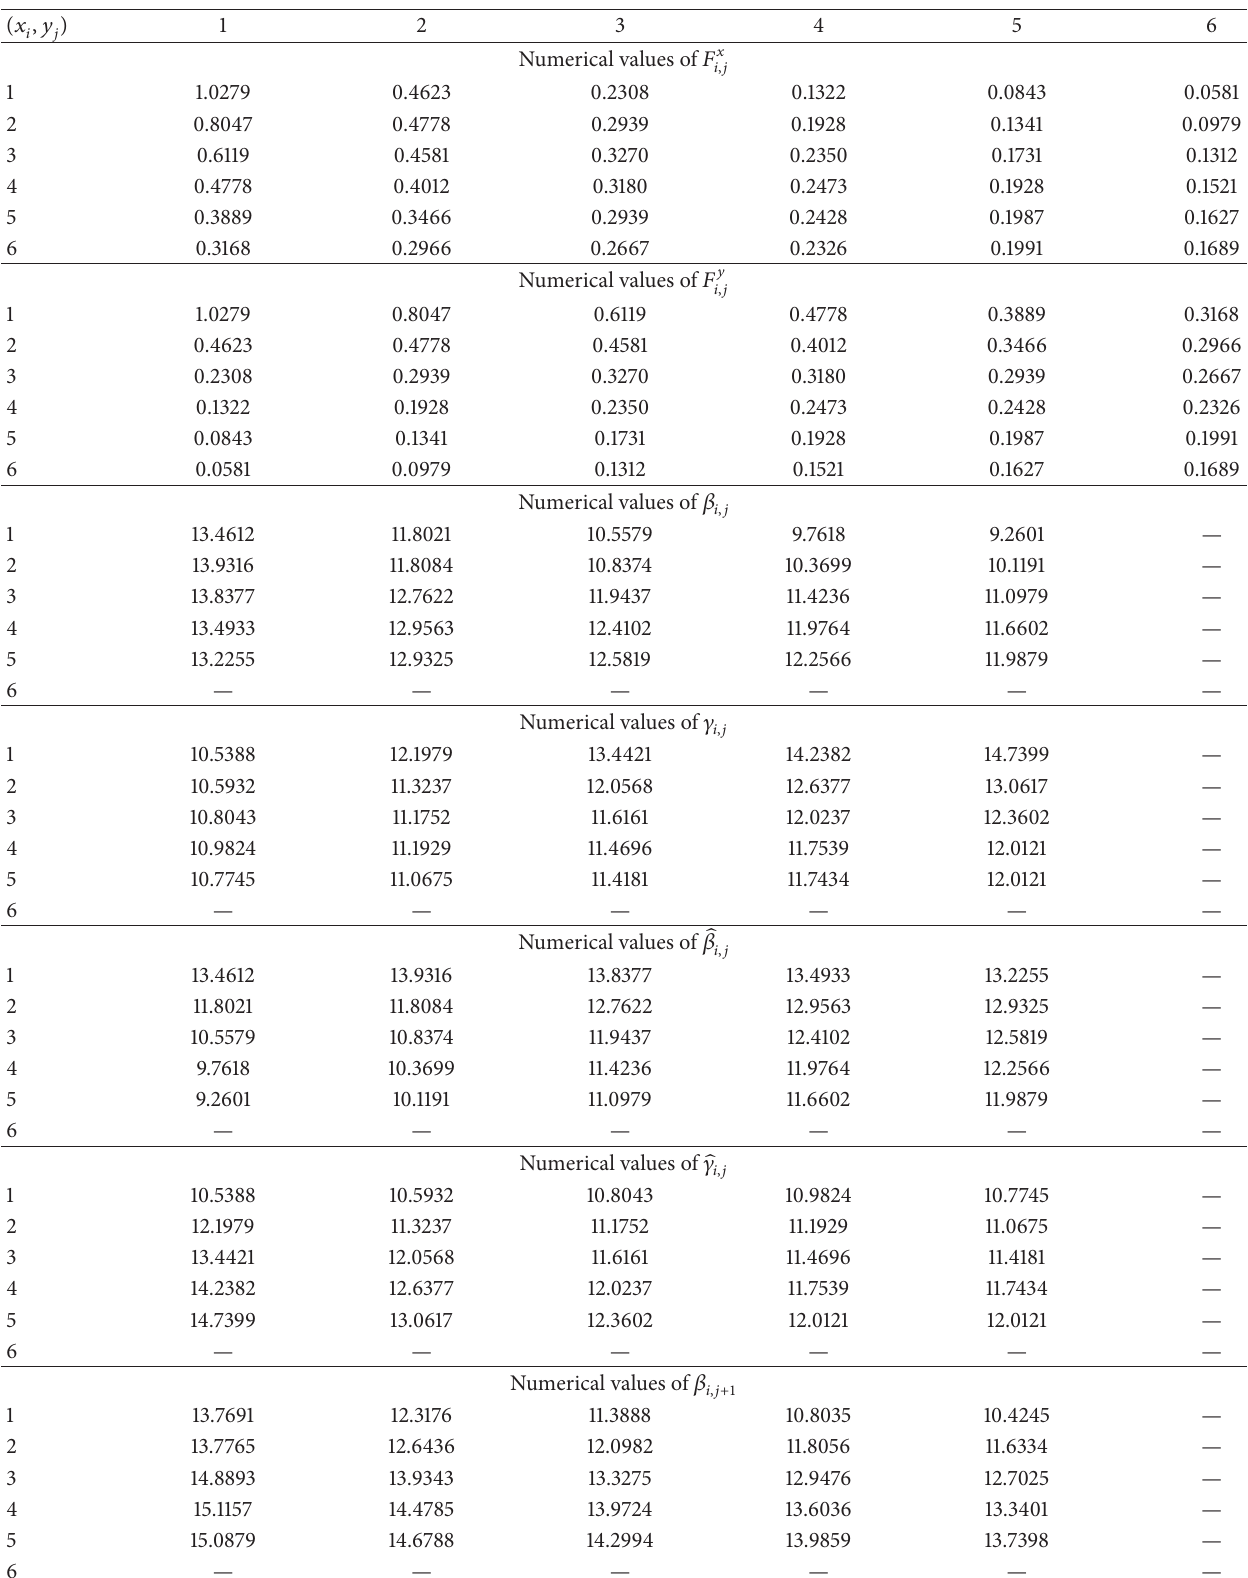
Table 8: Numerical values corresponding to Figure